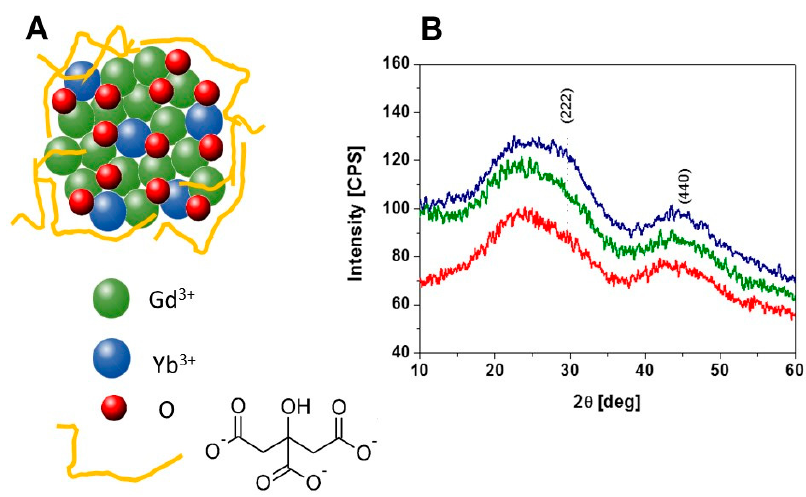
Figure 1. ( A ) Schematic view of Gd 2 O 3 :Yb nanoparticles covered on the surface with citrate; ( B ) X-ray profiles of Gd 2 O 3 (red), Gd 2 O 3 :Yb (LL) (green), and Gd 2 O 3 :Yb (HL) (blue).